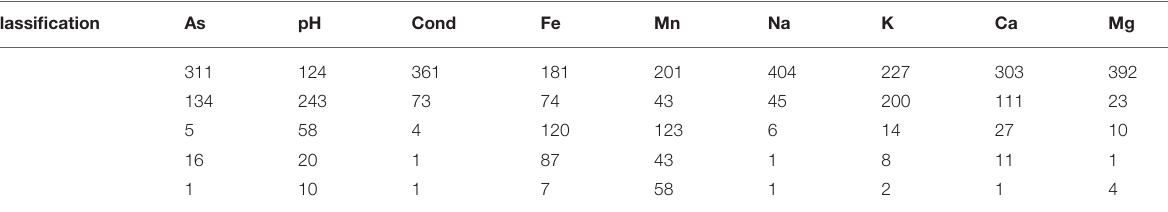
TABLE 2 | Number of sites per interval classification (refer to Figure 3 for classification). Classification